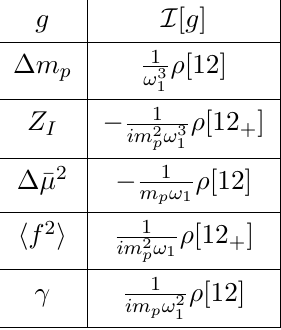
Table 1 . Quadratic Couplings (general environment).